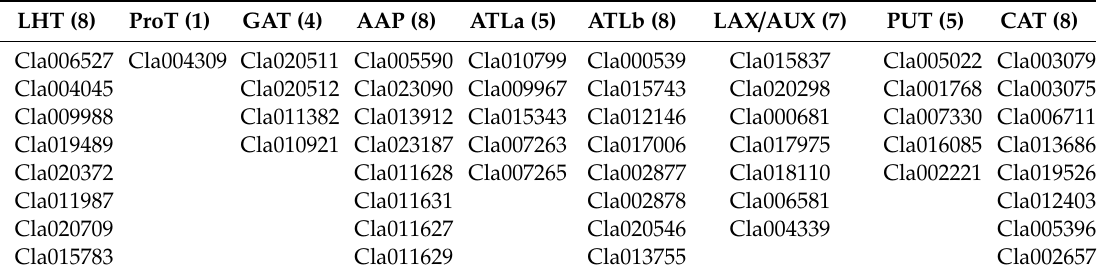
Table 1. Putative amino acid transporters from watermelon. LHT: lysine histidine transporter; ProT: proline transporter; GAT: GABA transporter; AAP: amino acid permeases; ATLa: amino